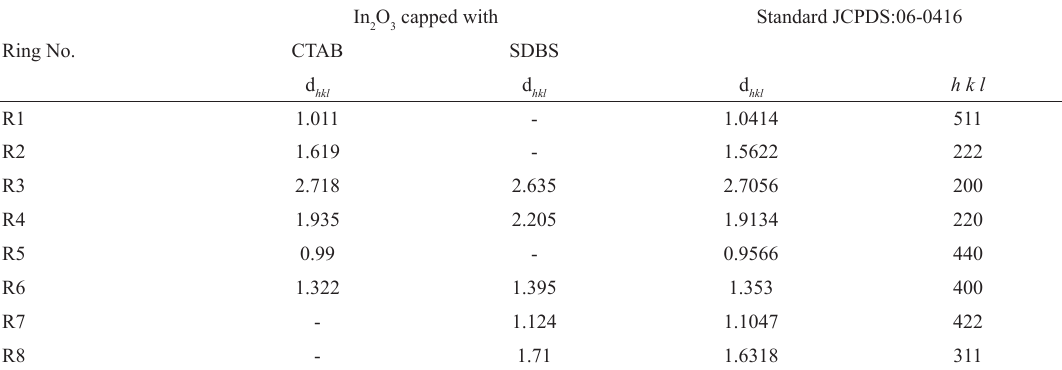
O samples capped with CTAB and SDBS from SAED patterns of Fig.4 with standard JCPDS(06-0416)data 2 3